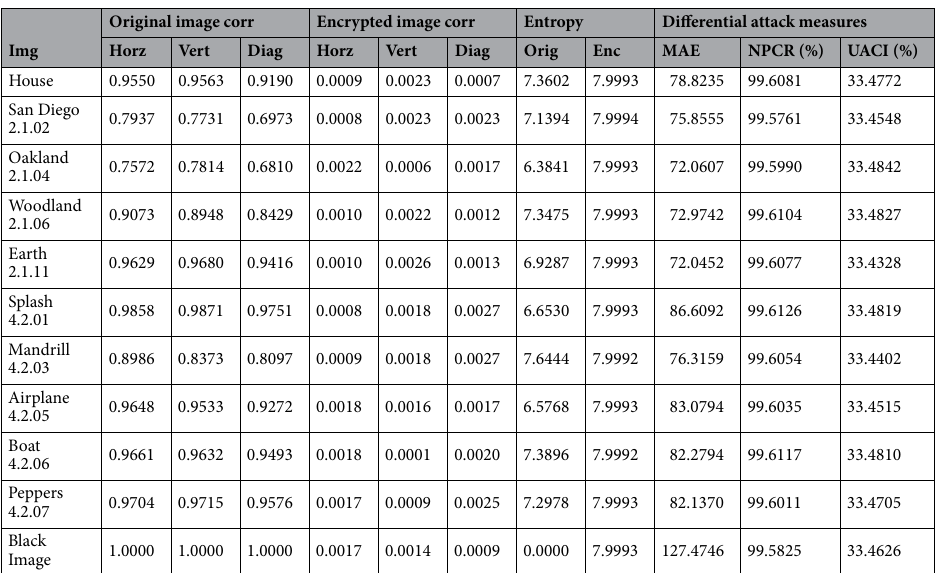
Table 10. Analysis results for some images from the USC-SIPI image database and the black image.